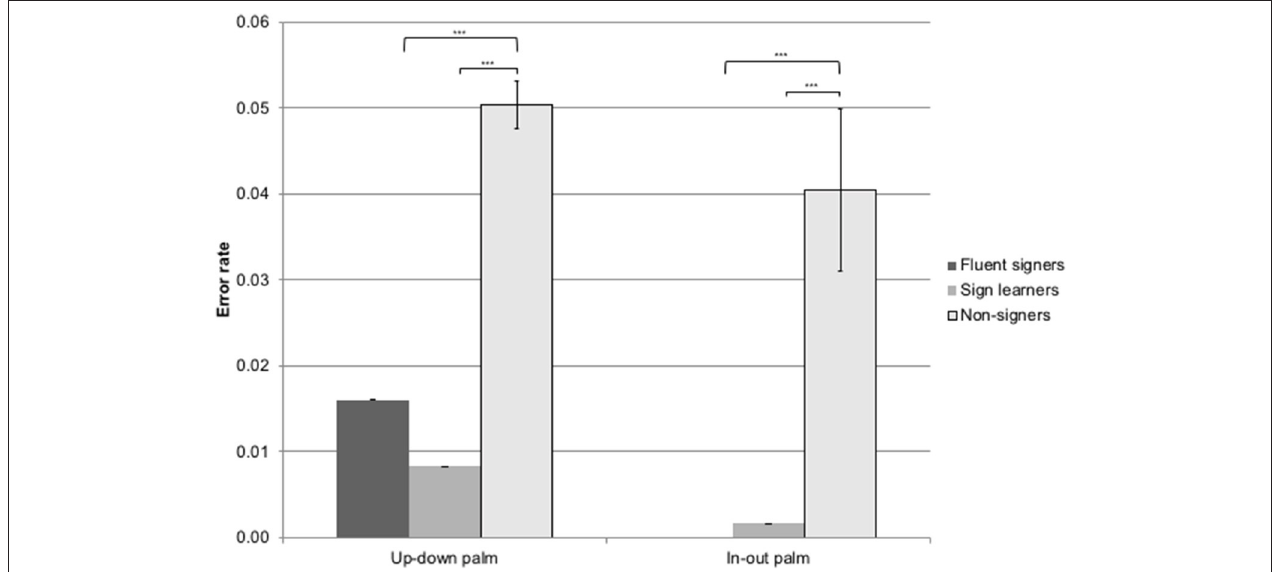
FIGURE 5 | Error rate by palm orientation type for non-signers, sign learners, and fluent signers. *** p < 0.001.